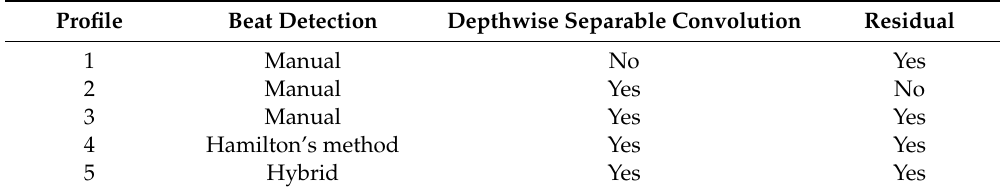
Experimental scenarios using ECG-ID and MIT-BIH databases with various CNN